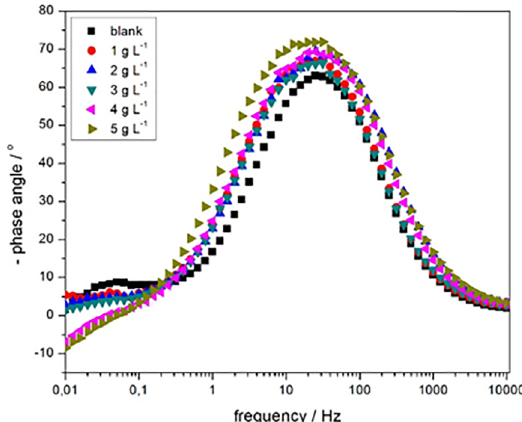
Figure 6. Nyquist diagrams for AISI 304 stainless steel in H in presence and absence of AEAW.